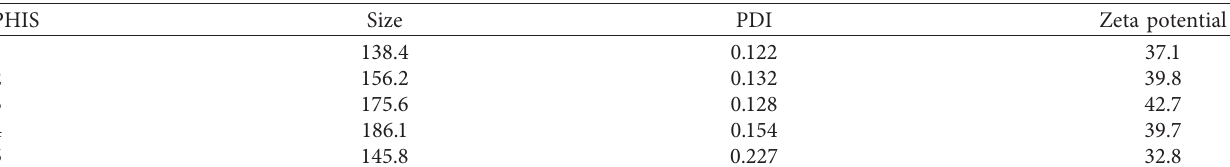
Table 4: Particle size, PDI, and zeta potential of PHIS with different mass ratios.